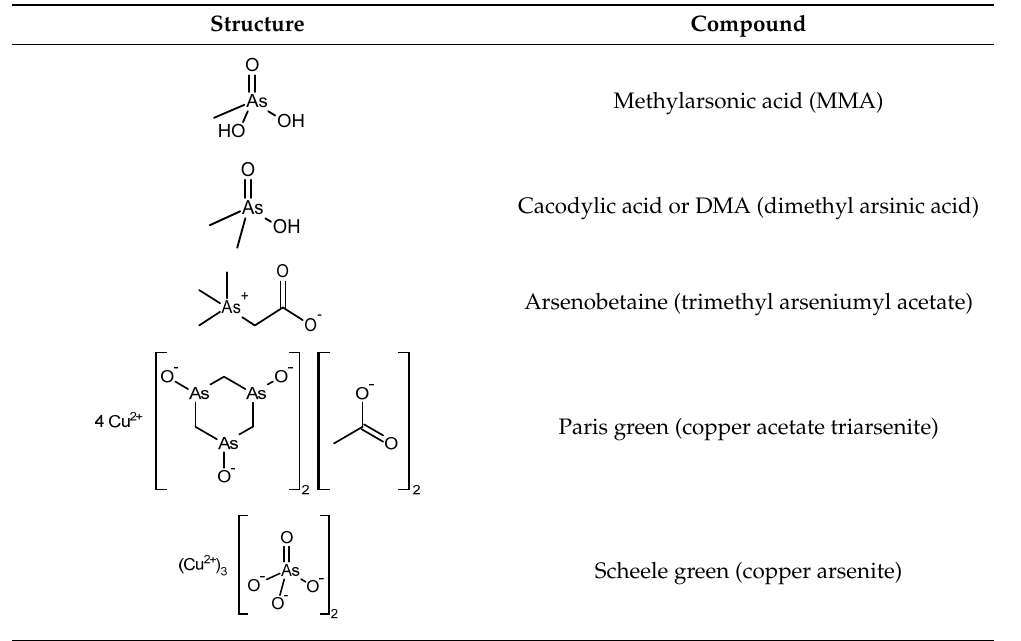
Table 2. Arsenic-containing compounds.